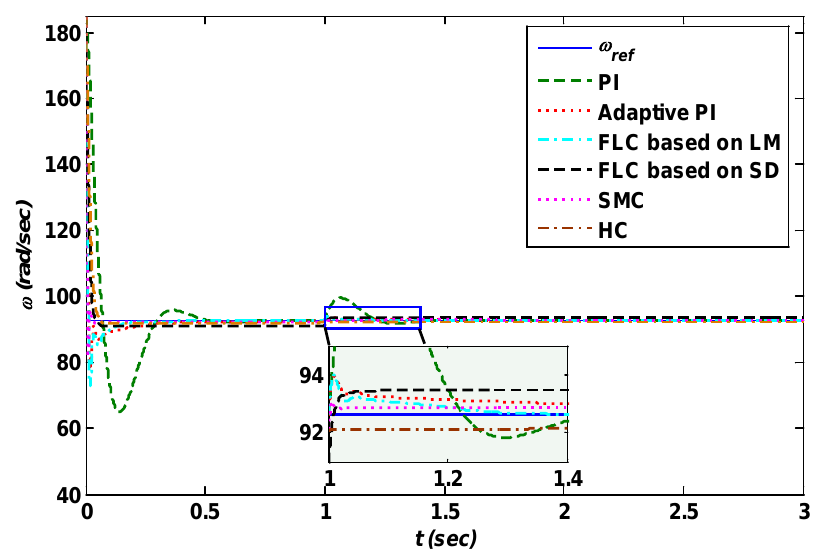
Figure 21. Load disturbances in presence of speed variation. Energies 2018 , 11 , x FOR PEER REVIEW